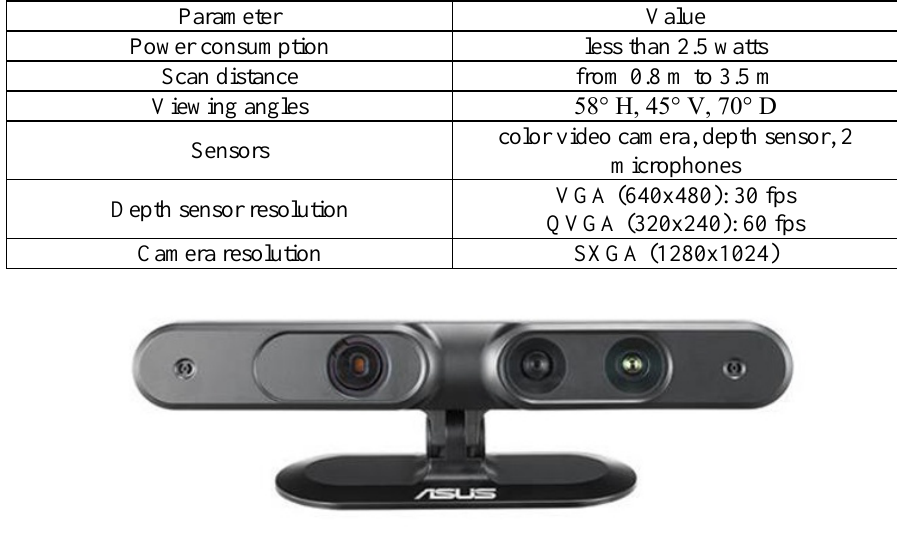
Fig. 1. The appearance of the selected